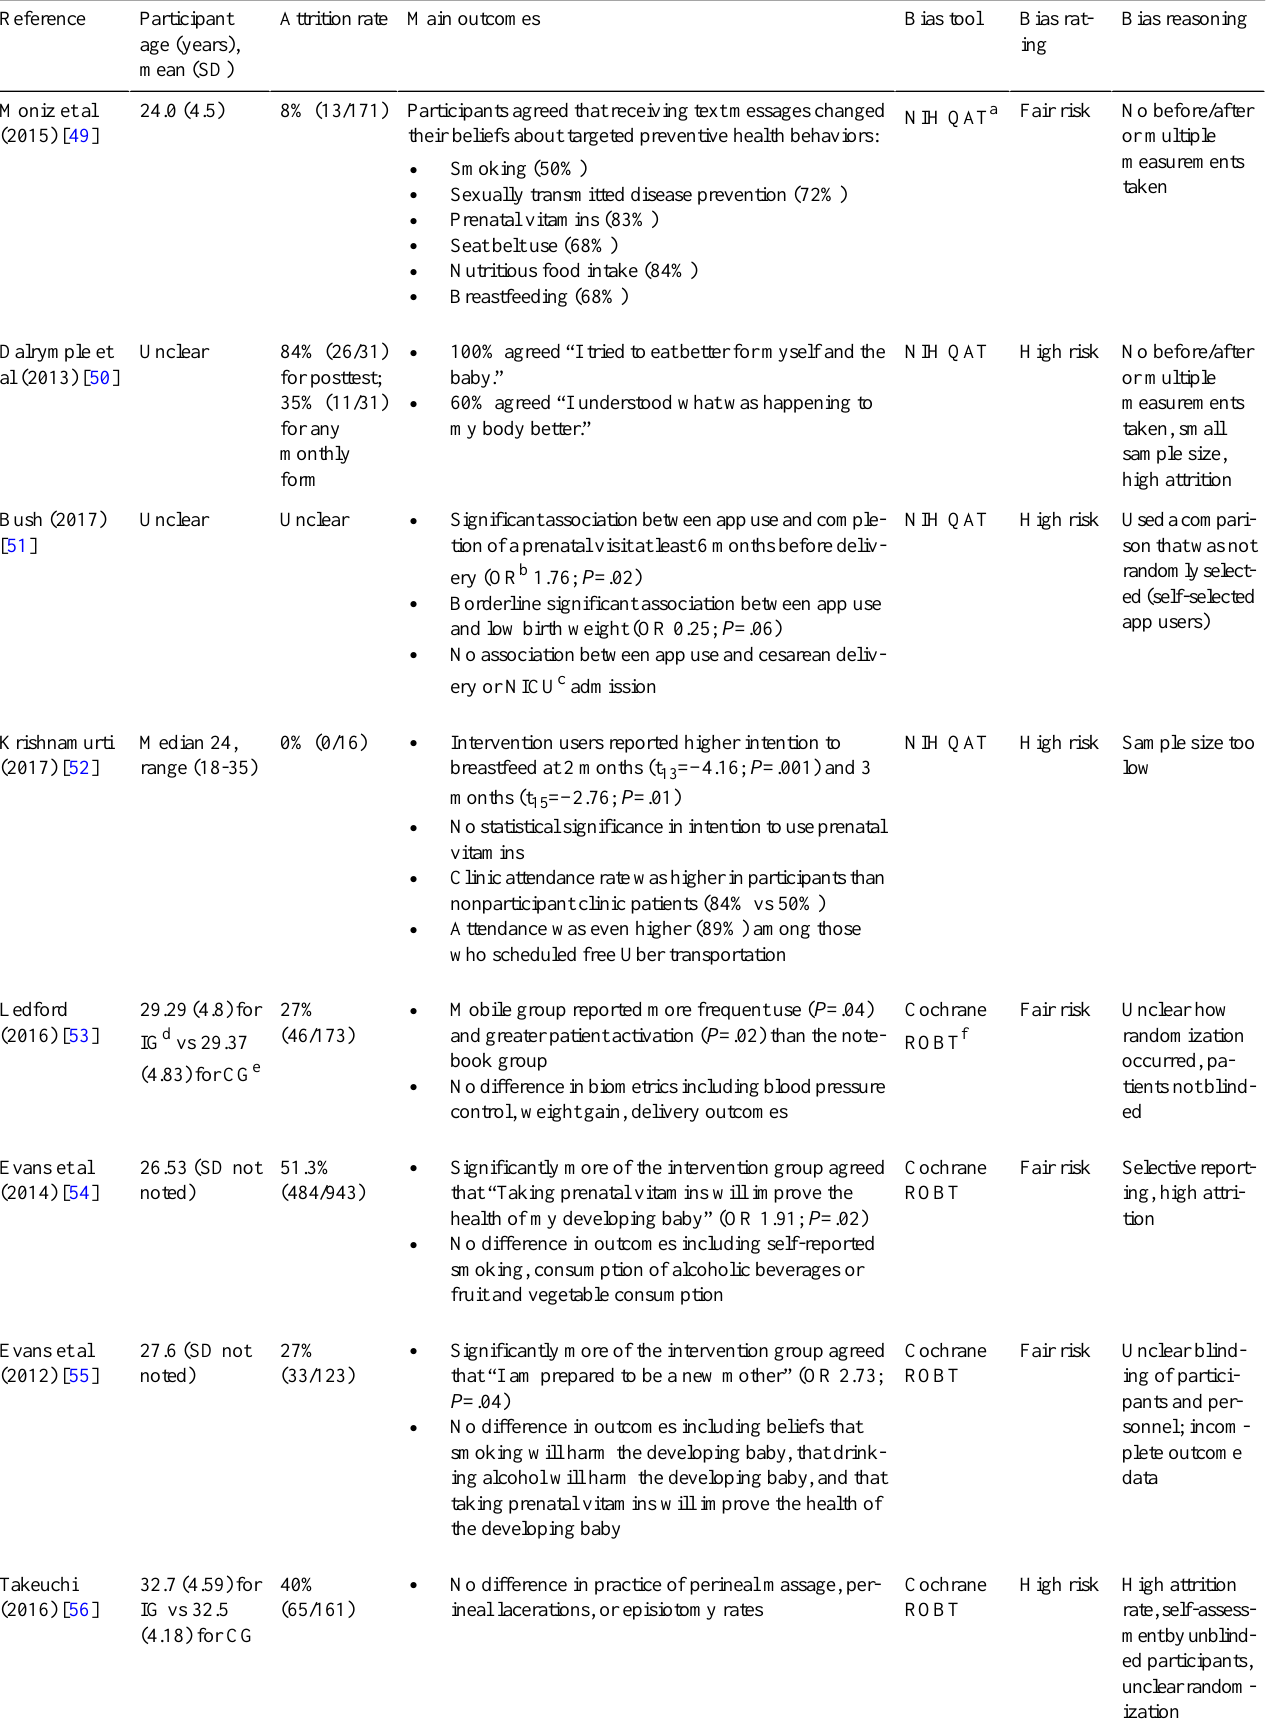
Table 8. Outcomes and bias of trials with a focus on general health, preventive health, health beliefs, and other